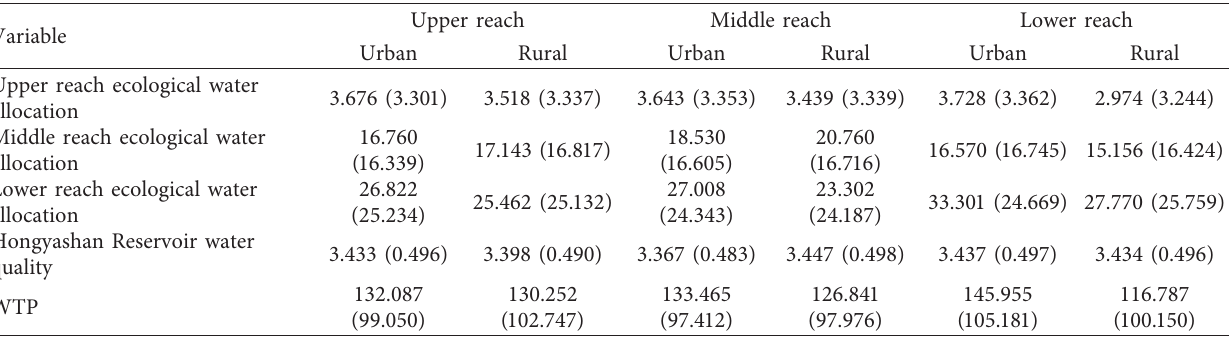
Table 3: Variable descriptive statistics.